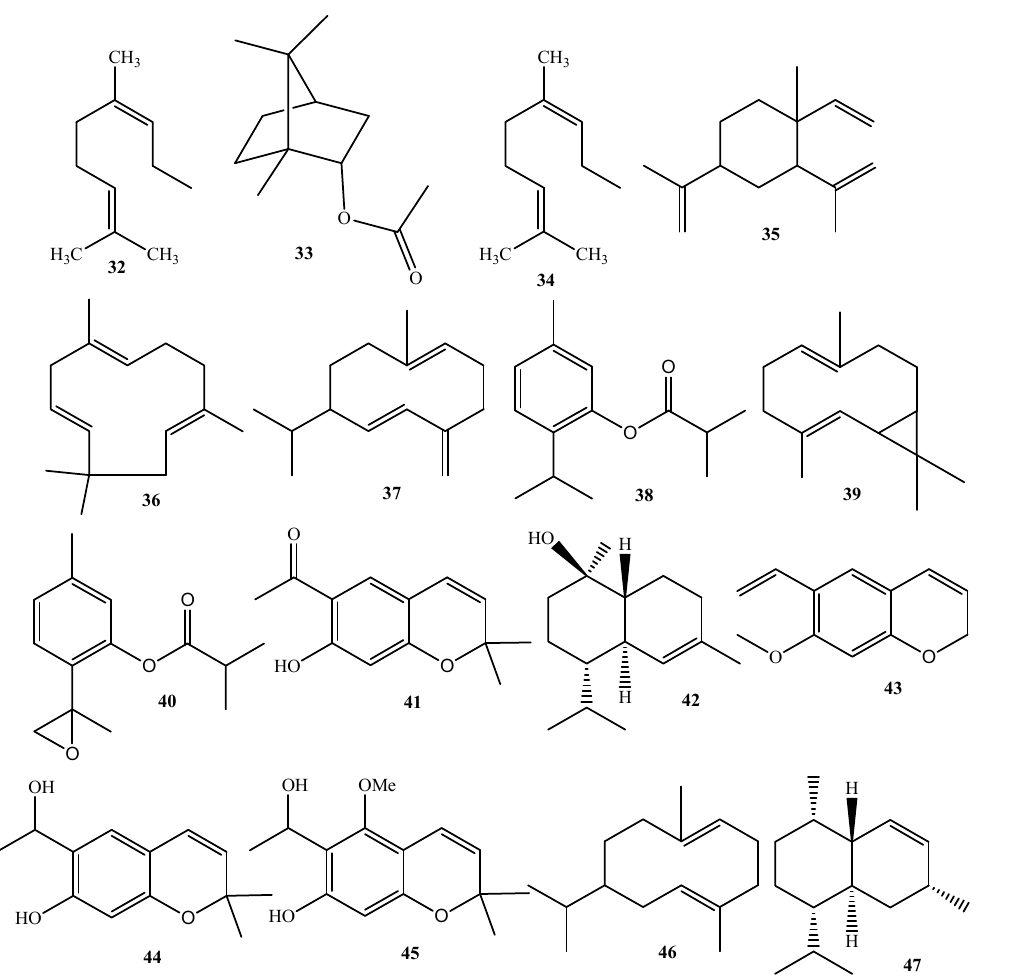
Figure 5. Structures of the reported chemical compounds of essential oils from A.